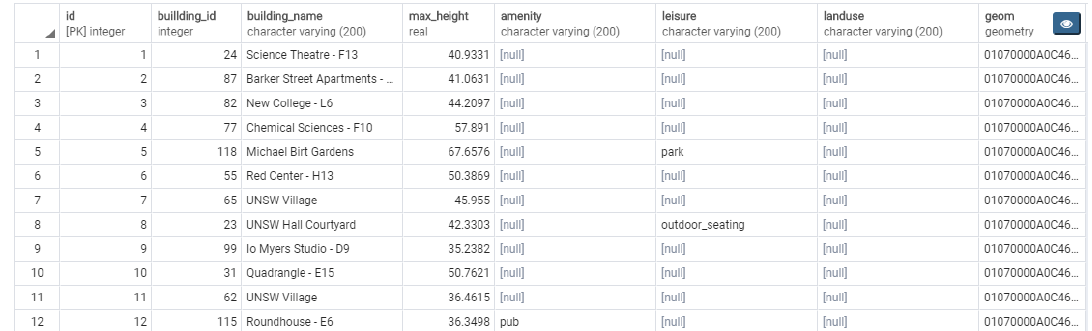
Figure 17. Example of a table stored in PostgreSQL to store building